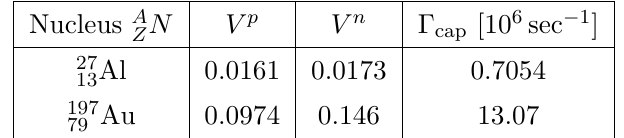
Table 3 . A summary of parameters for the (cid:22) (cid:0) e conversion formula for 27 clei [52,